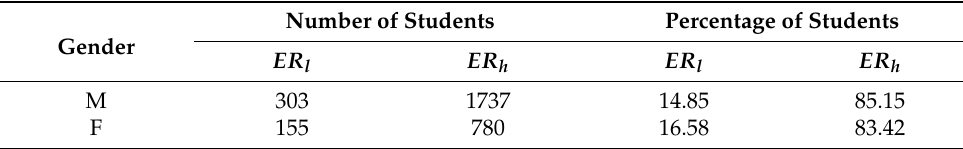
Table 7. Academic performance indicator values by semester per economic